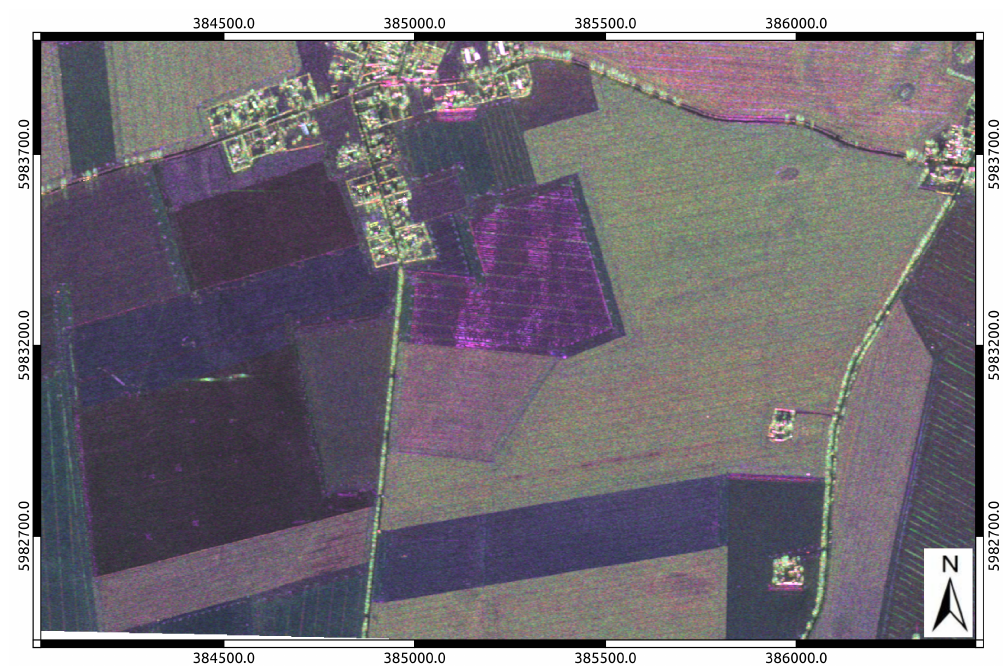
Figure 4. Composite of backscatter values for April 19th using different polarizations (R: VV, G: VH, B =